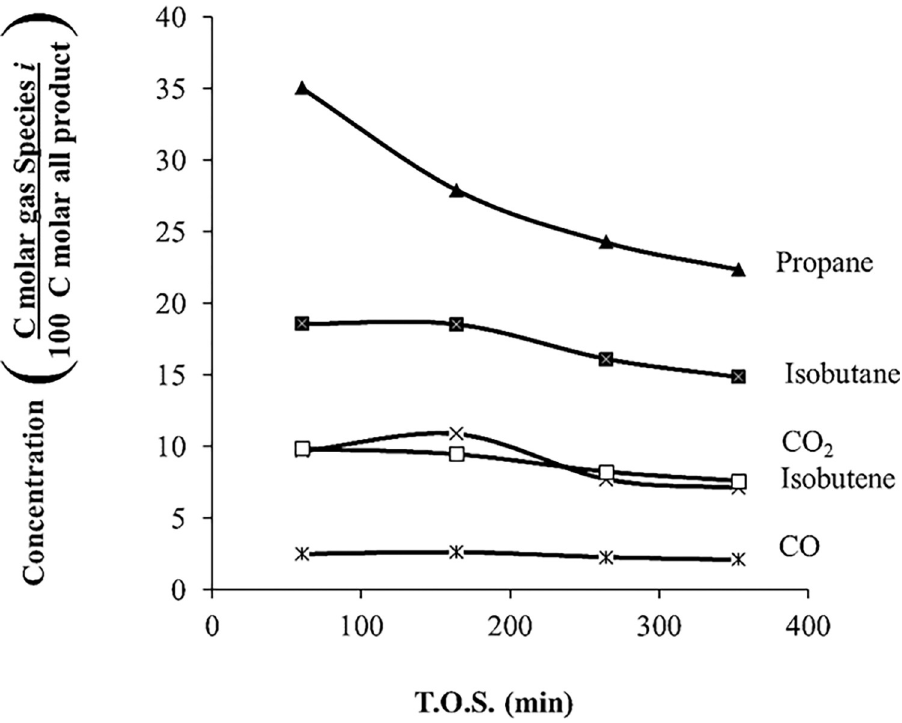
Fig 4. Product distribution of gases for the acetone reaction over HZSM-5(80), T = 415˚C, WHSV = 1.3 h –1 , and P = 101 kPa